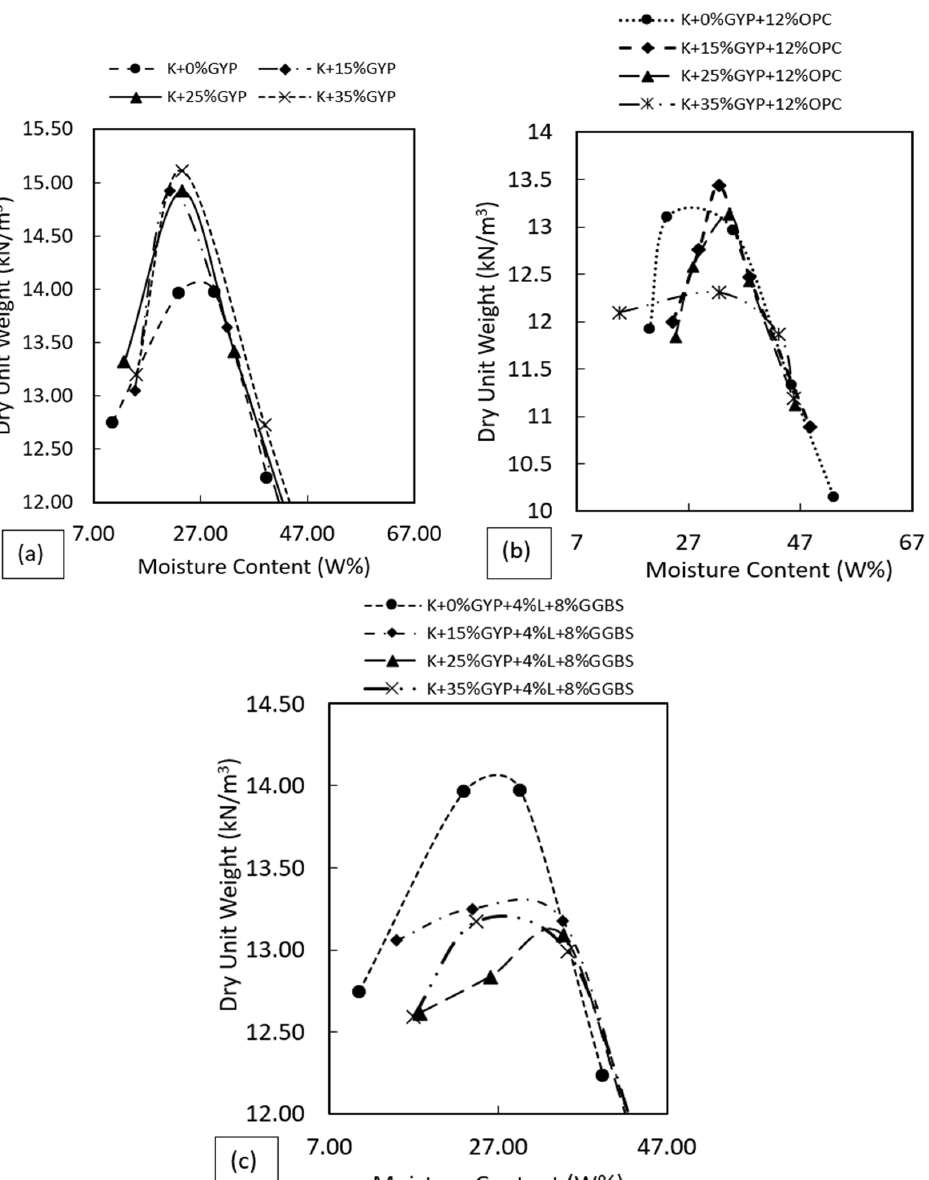
Figure 5. Compaction curves of the treated and untreated gypseous soils. ( a ) Untreated gypseous soils. ( b ) 12%OPC treated. ( c ) 4%L and 8%GGBS treated. soils. ( b ) 12%OPC treated. ( c ) 4%L and 8%GGBS